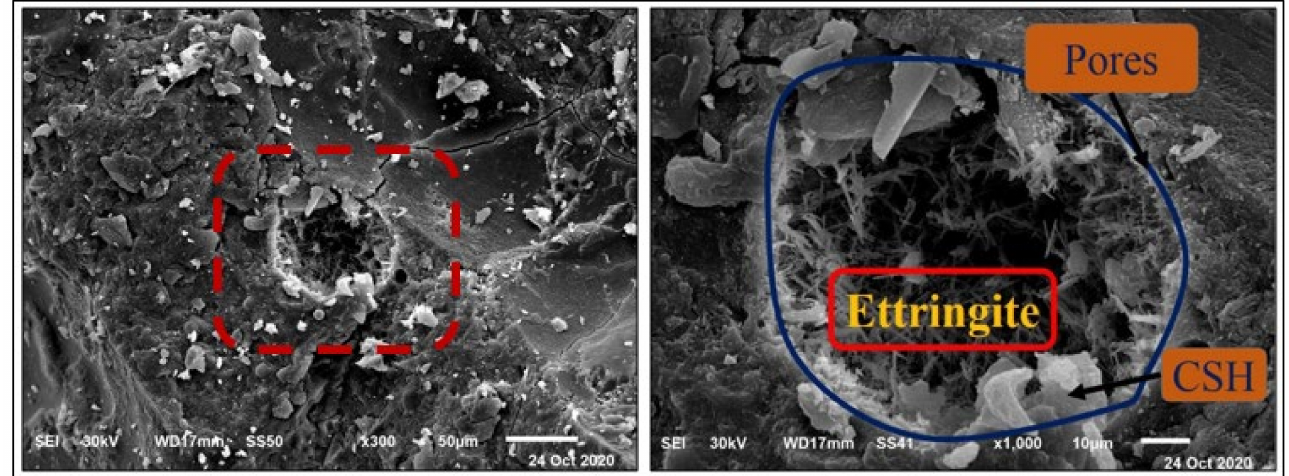
Figure 17. Ettringite formation and pore filling in Z0 concrete at 90 days.